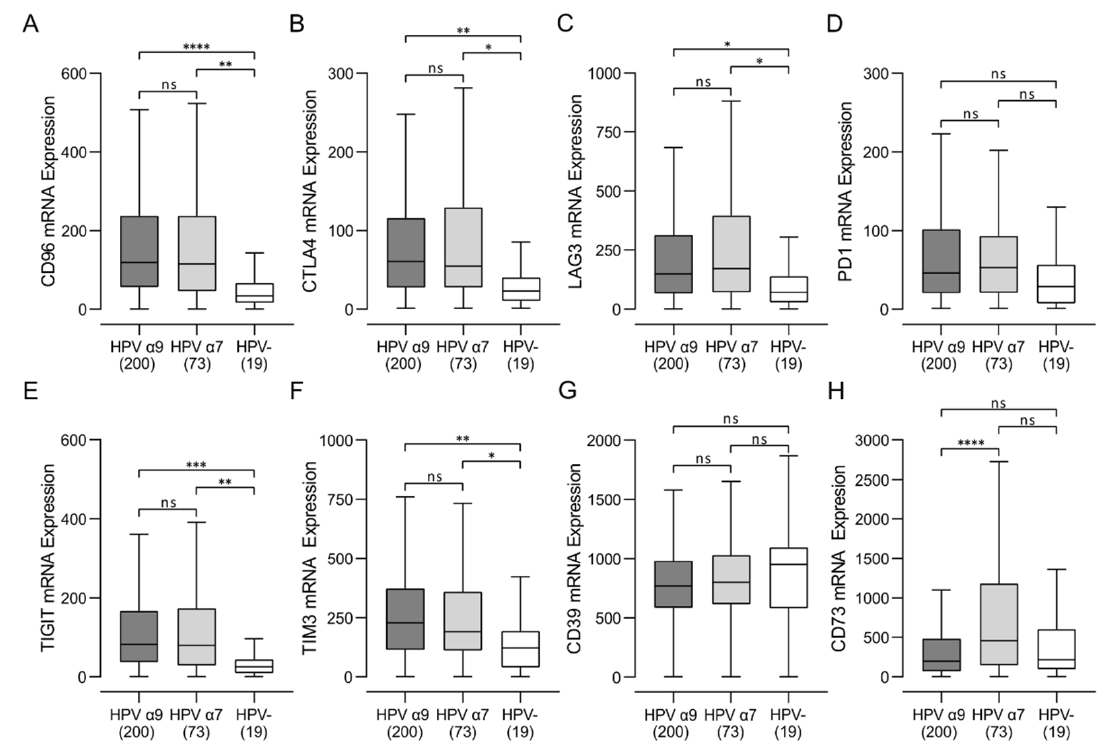
Figure 6. Analysis of immune checkpoint markers in HPV-positive (HPV α 9 and HPV α 7) and HPV-negative (HPV-) cervical cancers. ( A – F ) Expression of marker genes related to T-cell exhaustion markers, including CD96, CTLA4, LAG3, PD1 (PDCD1), TIGIT, and TIM3 (HAVCR2). ( G , H ) Expression of marker genes related to immunosuppressive purinergic signals including CD39 (ENTPD1) and CD73 (NT5E). Numbers in brackets refer to the number of samples included in each analysis. **** p ≤ 0.0001, *** p ≤ 0.001, ** p ≤ 0.01, * p ≤ 0.05, ns (not significant).